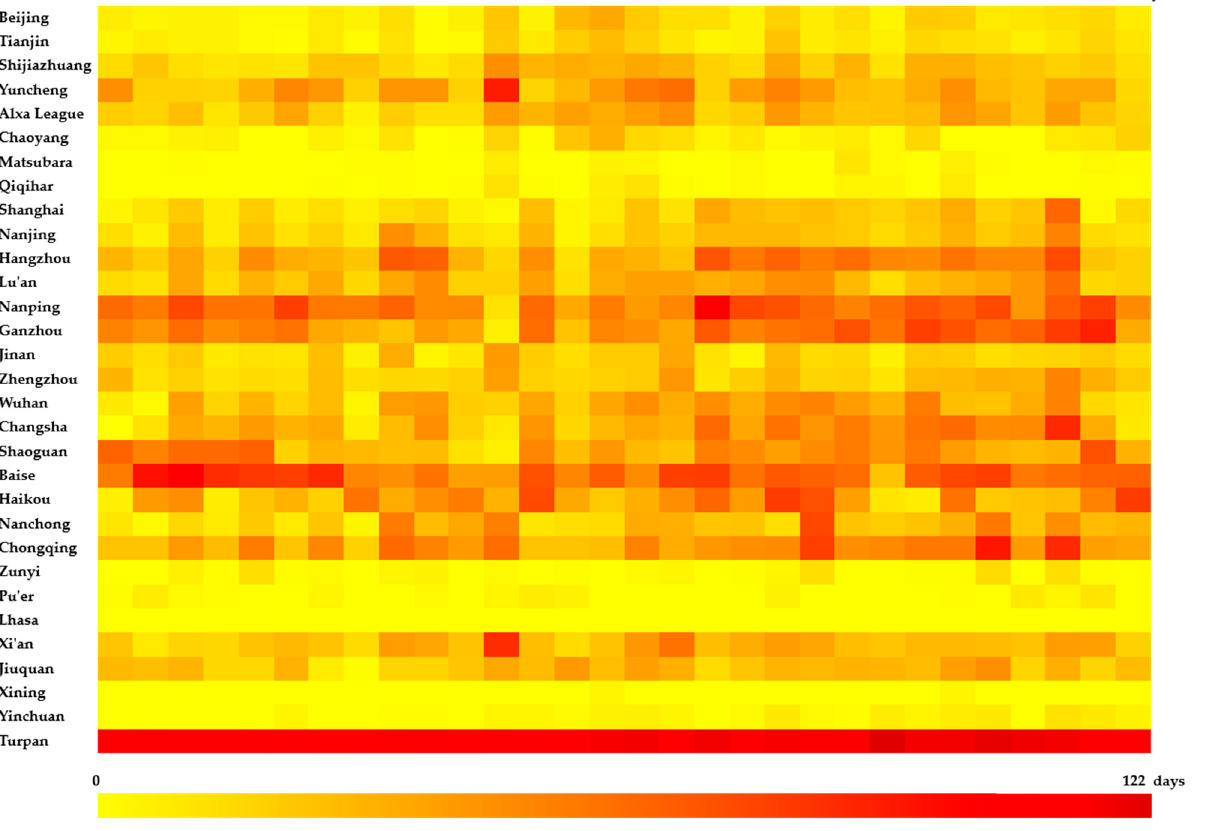
Figure 2. Number of high-temperature days ( ≥ 35 °C) in 31 typical Chinese cities from 1986 to 2015.